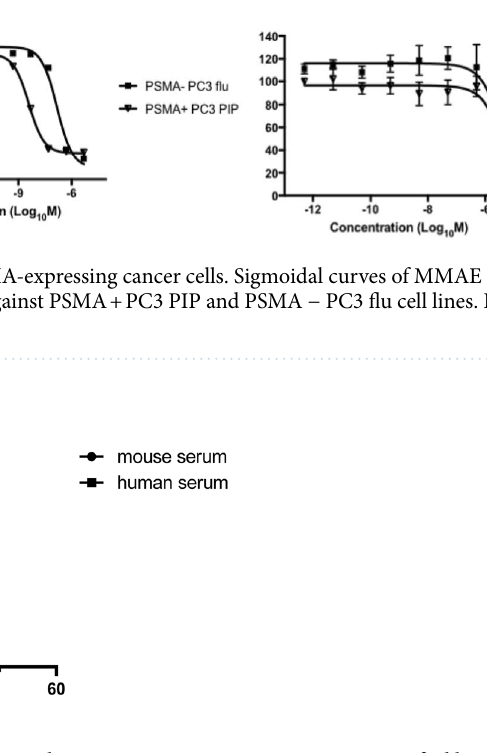
Figure 3. SBPD-1 is more stable in human than in murine serum. SBPD-1 was quantified by HPLC at various times after incubation with human or murine